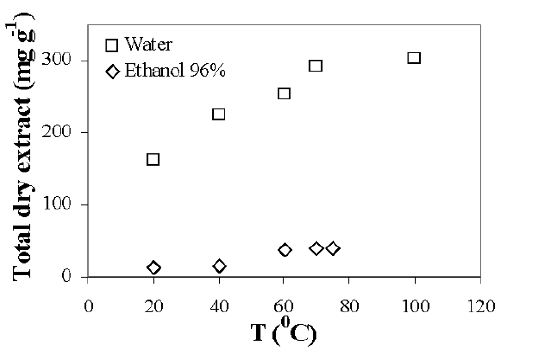
Figure 5. Amount of total dry extract at different temperatures.